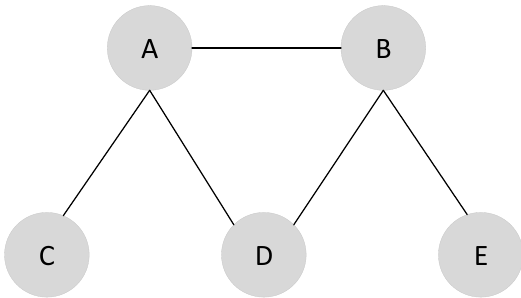
Figure 1. An illustration of the relation between four IDS related problems. Given a graph G = ( V , E ) where V = { A , B , C , D , E } : (a) assuming that the weight values of all vertices is 1, then { A , E } is one MIDS solution of this given graph; (b) assuming each vertex has weight value such that w ( A ) = 1, w ( B ) = 2, w ( C ) = 2, w ( D ) = 3, w ( E ) = 4 and each edge has a weight value such that w ( e AB ) =